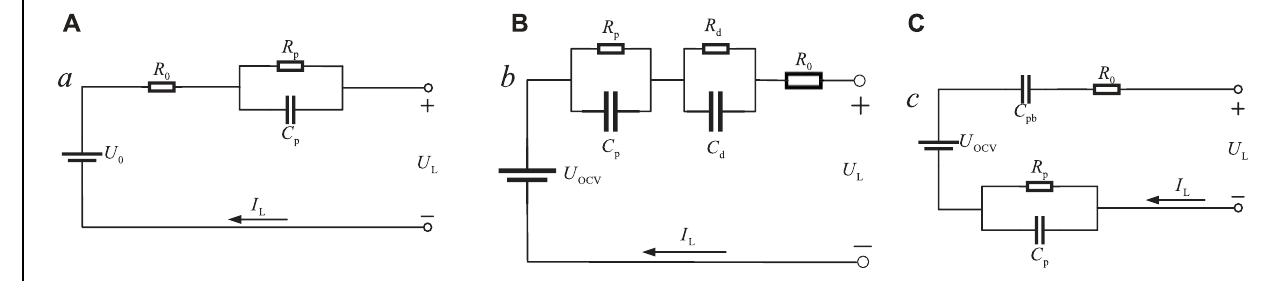
FIGURE 1 | Battery model. (A) Thevenin model. (B) SECM. (C)